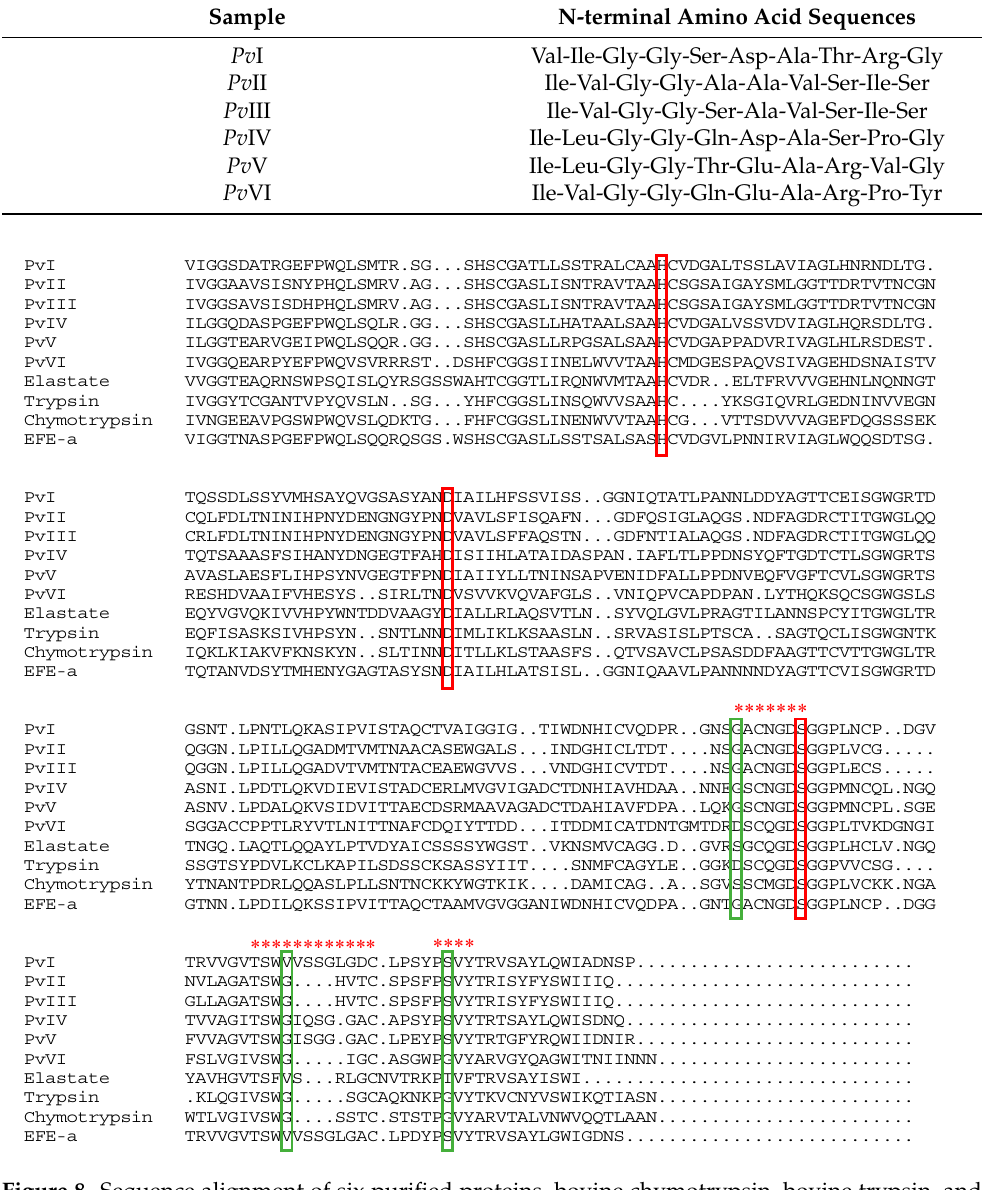
Figure 8. Sequence alignment of six purified proteins, bovine chymotrypsin, bovine trypsin, and porcine elastase. The amino acid residues of the catalytic triad (red box) and the entrance of the substrate-binding pocket (green box) are represented. The residues in the S1 pocket are marked with red asterisks.